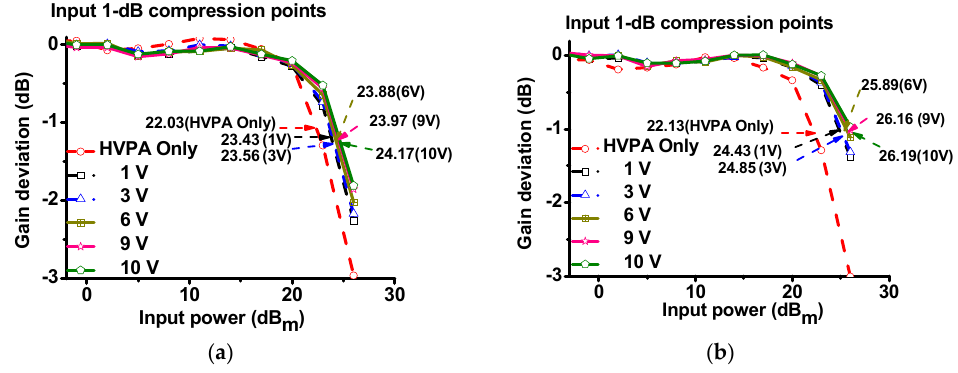
Figure 8. Measured 1-dB compression point graphs of the HVPA with and without power MOSFET linearizer at ( a ) 70 MHz and ( b ) 80 MHz under DC bias voltages (1, 3, 6, 9, and 10 V DC, respectively).